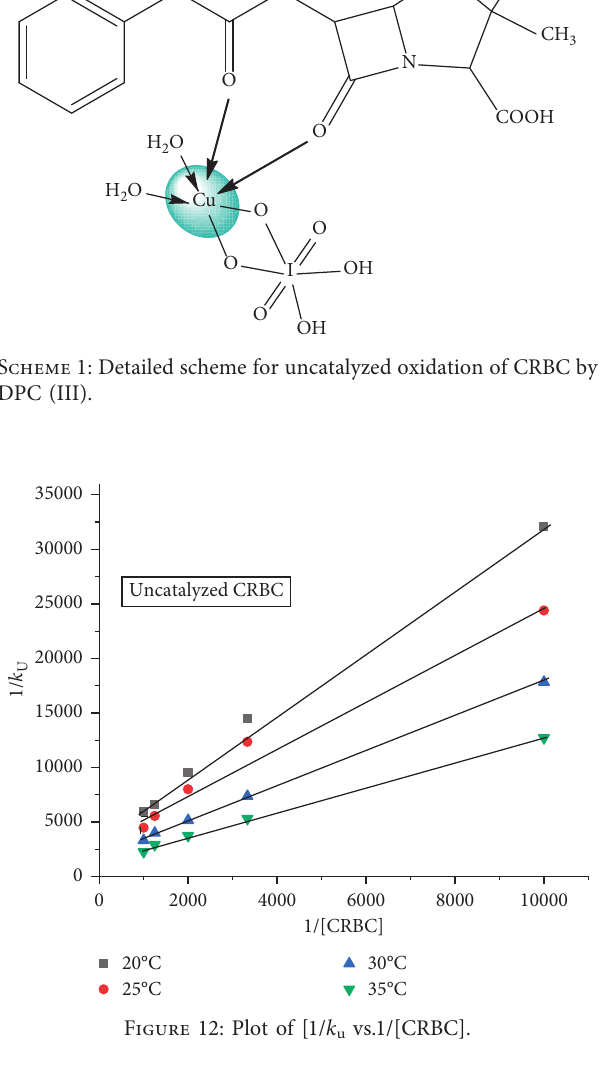
Figure 14: Plot of [1/ k